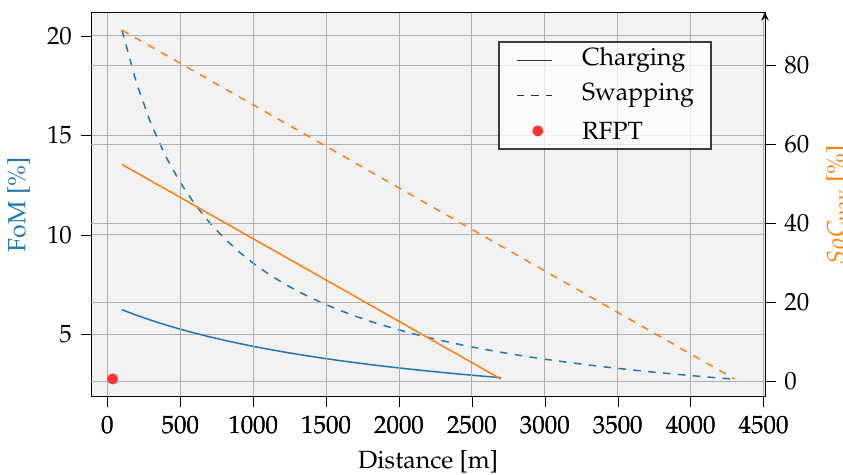
Figure 18. FoM comparison according to the parameters from Table 6. Table 6. Proposed parameters to compare charging process against swapping process. Parameters Charging